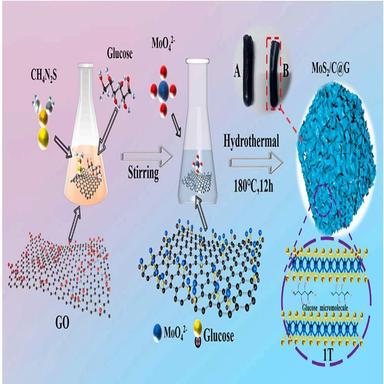
(a) Flow chart of composite material preparation.